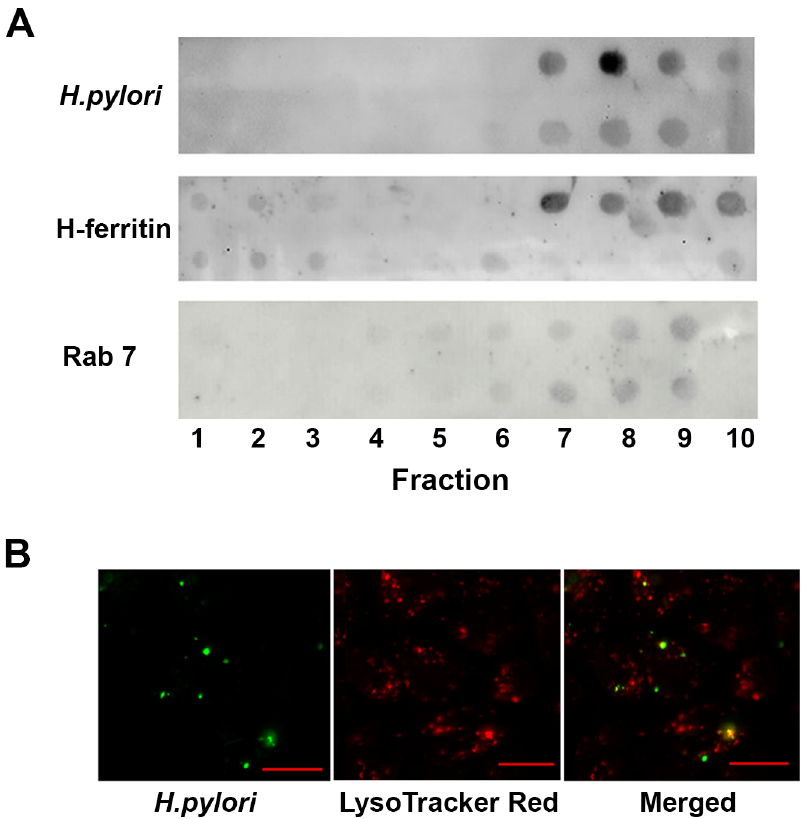
Fig 3. H . pylori co-localise with ferritin in Rab7-rich compartments within AGS cells. (A) Phagosomes were collectedfrom lysed AGS cells followinginfection with H . pylori strain 60190 (MOI, 10:1) for 15 h (top) or not (bottom) by sucrose density gradientcentrifugation. Ten (top down) fractions were blotted onto PVDF membraneand probedwith antibodiesto H . pylori Lpp20, H-ferritin and Rab7. Antibodybindingwas visualisedusing a chemiluminescent detectionof HRP-conjugated secondaryantibody binding.Images are representative for three independentexperiments. (B) AGS cells infected with DiO-labelled H . pylori strain 60190 and stainedwith LysoTracker Red are shown individuallyand in a mergedimage. Bar = 20 μ